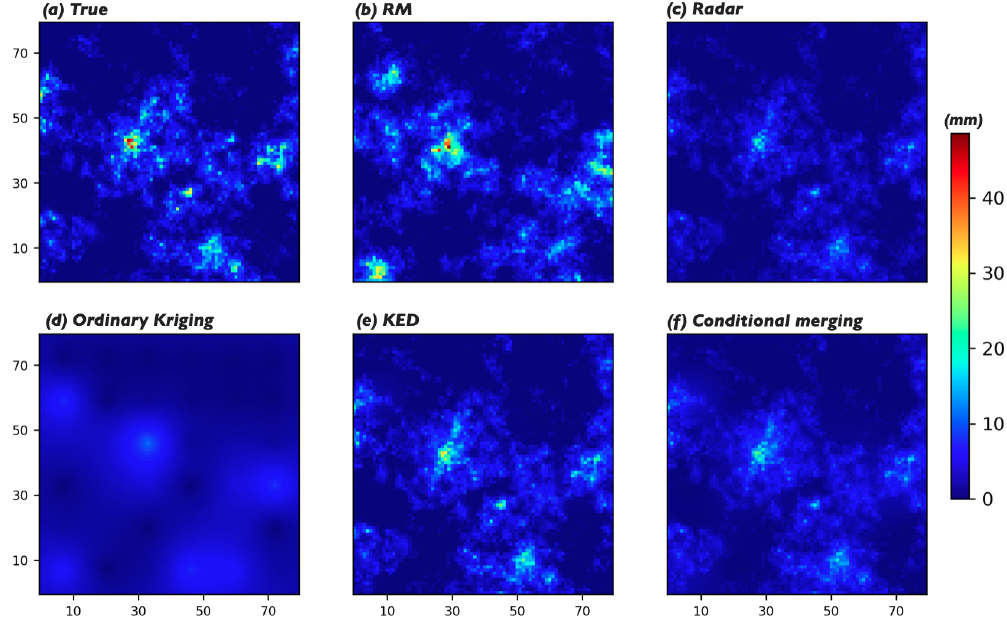
Figure 5. (a) The true rainfall field; (b) a single realization from RM (scenario: G36, SNR = 3); (c) the radar estimates; (d–f) the estimates obtained from ordinary Kriging, Kriging with external drift (KED), and conditional merging,